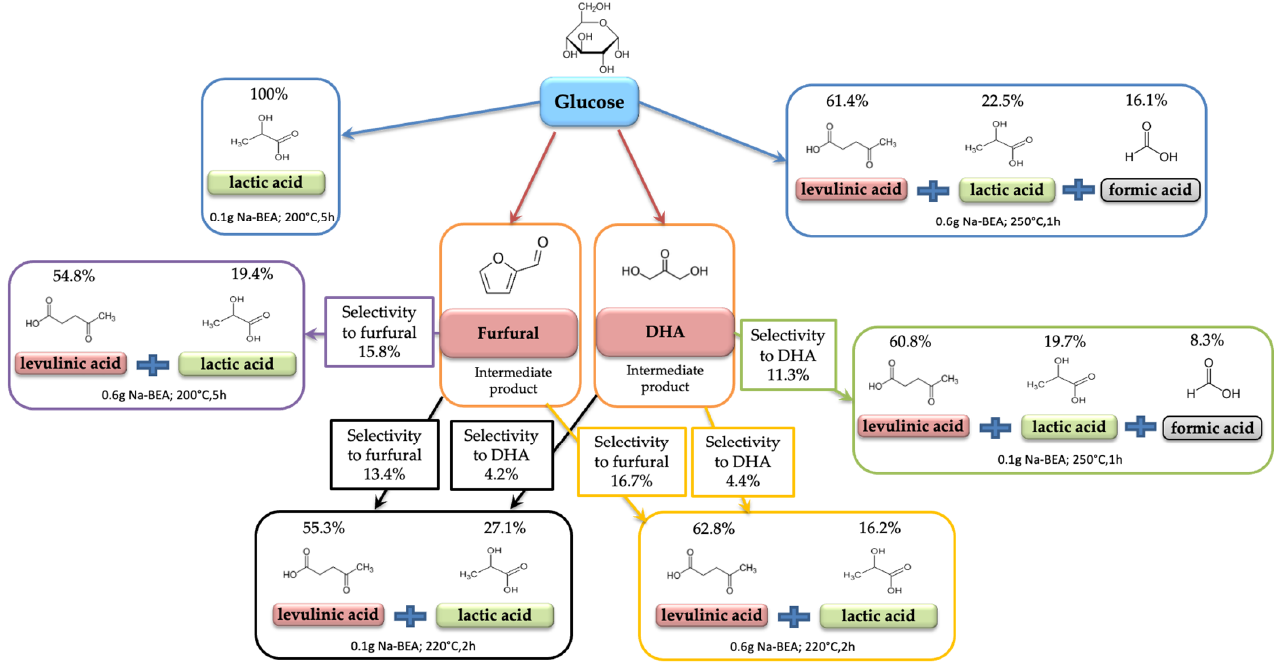
Figure 9. Summary of results based on HPLC analysis for heterogeneous catalysis during glucose conversion. The results are related to the selectivity to the given product.